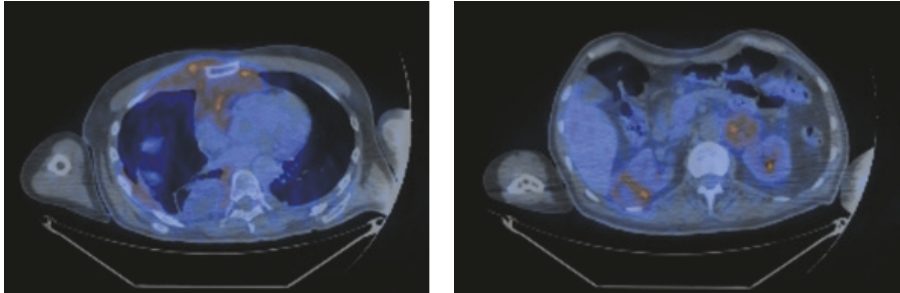
Figure 5: Slides from final PET scan showing metastatic spread with metabolic activity in multiple sites of the